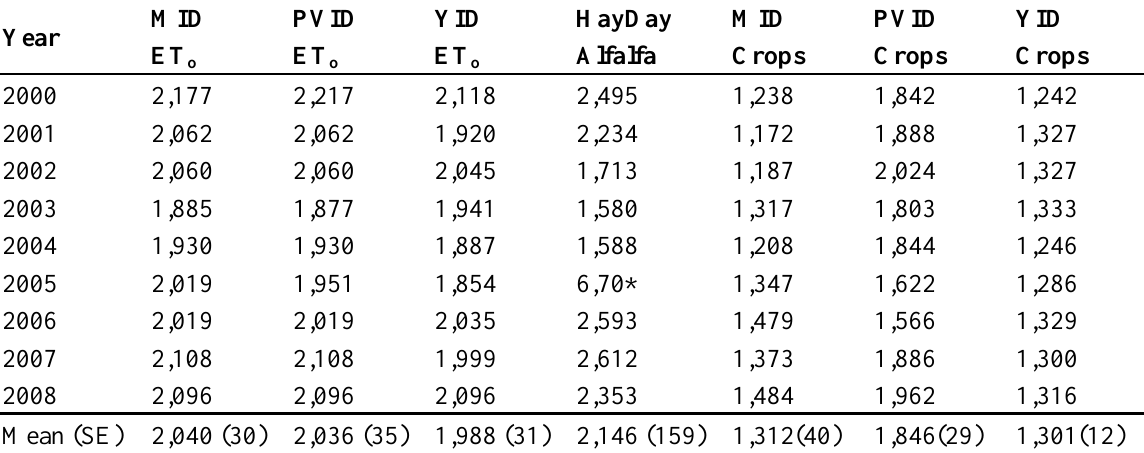
Table 2. ET estimates (mm yr −1 ) for agricultural areas on the Lower Colorado River based on MODIS Enhanced Vegetation Index from satellite sensors and ground measurements of ET . MID = Mohave Irrigation District; PVID = Palo Verde Irrigation District; YID – o Yuma Valley Irrigation